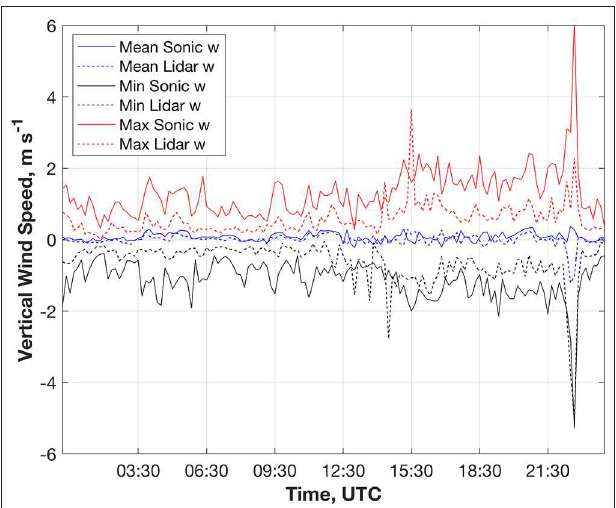
FIGURE 9 | Comparison of the 10min averaged, maximum, and minimum vertical wind speeds of the sonic anemometer and 29m lidar data at the One Energy calibration complex on 23 July